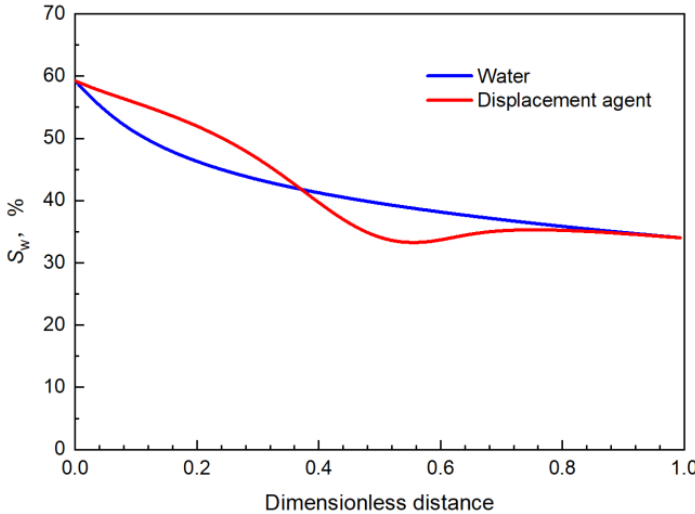
Figure 14. Comparison of water saturation distribution along the flow when the displacement time is 0.3 PV.